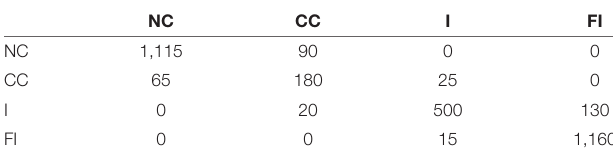
TABLE 4 | Confusion matrix of HMM trained with PAA 30 segments.